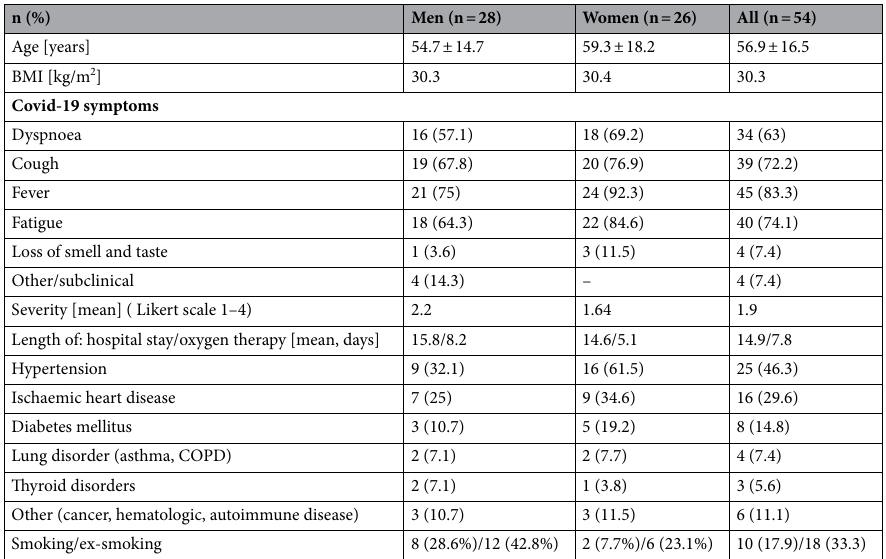
Table 1. Characteristics of patients hospitalized because of Covid-19.